Question: Which visualization type does this figure use?
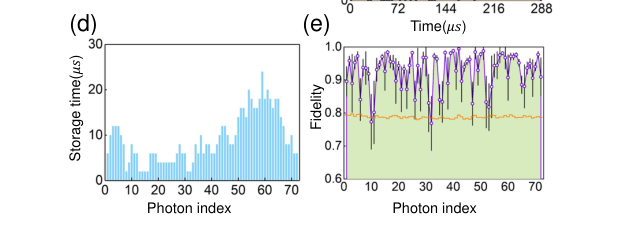
Answer: bar